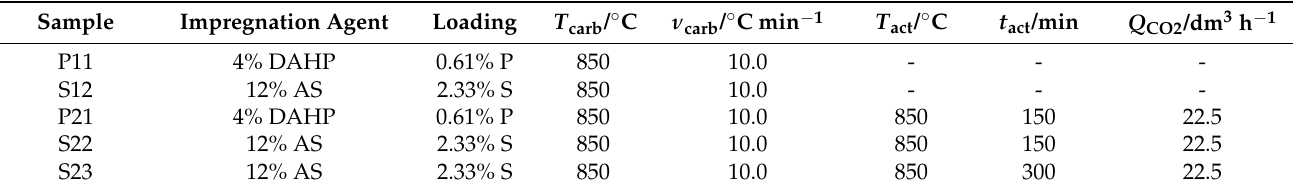
Table 1. Conditions of the sample